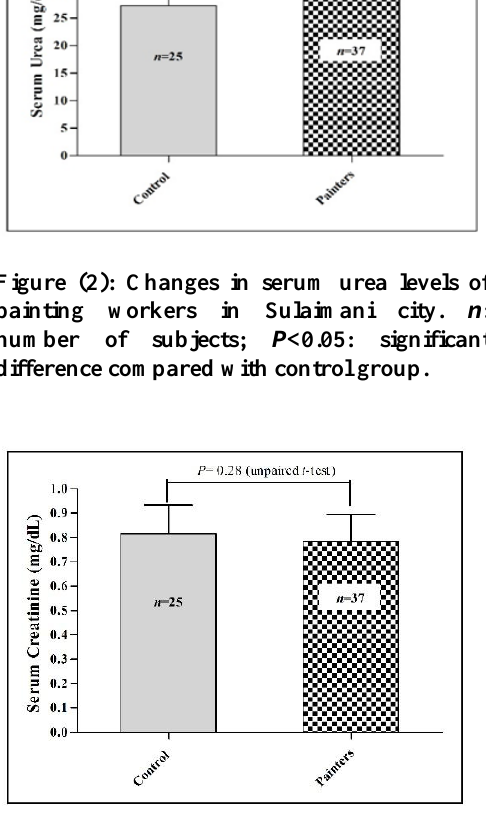
Figure (3): Changes in serum creatinine levels of painting workers in Sulaimani city. n : number of subjects; P >0.05: non-significant difference compared with control group .